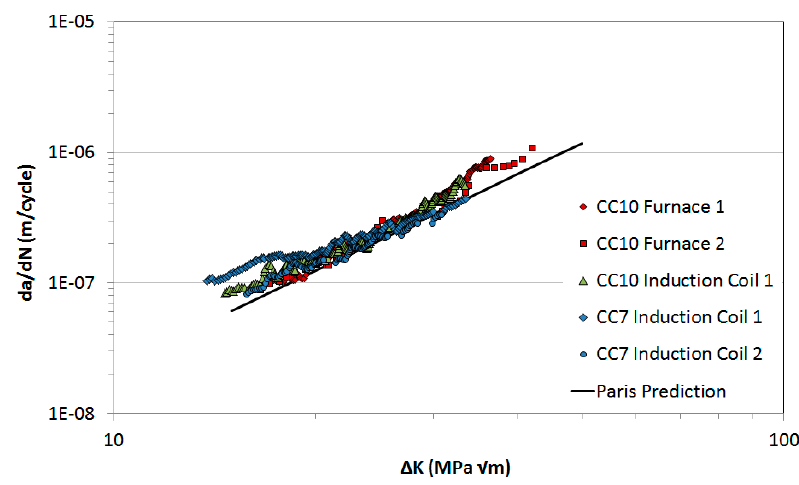
Figure 2. Waspaloy crack growth rates vs. stress intensity range: furnace and induction coil comparisons at 650 °C, 450 MPa and R = 0.1.